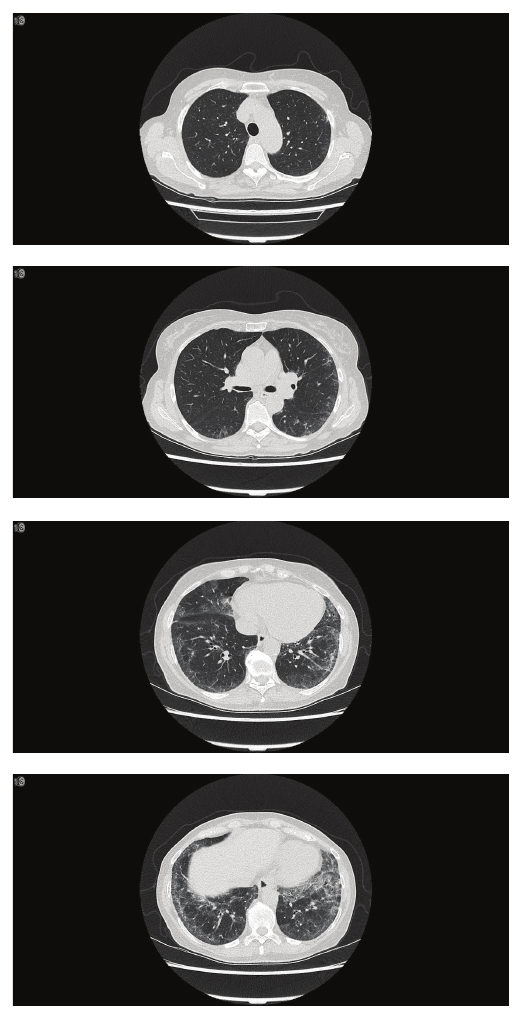
Figure 2: Chest computed tomography (CT) images showing lower lung zone predominant ground glass attenuation and reticulations